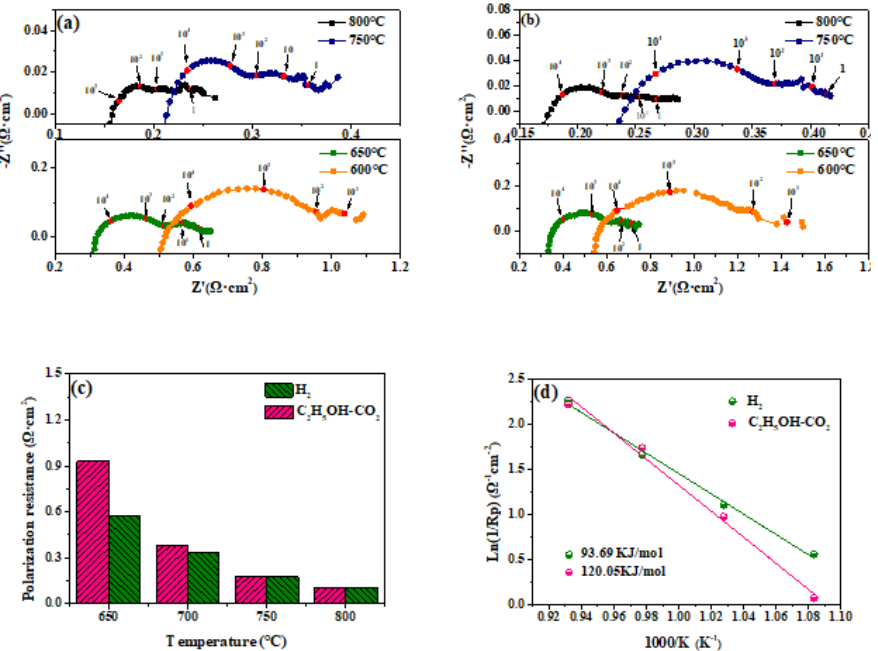
Figure 7. EIS of single cell with N-LSCFC-GDC reforming catalyst from 800 °C to 650 °C in ( a ) H 2 (~3% H 2 O) and ( b ) C 2 H 5 OH-CO 2 atmosphere; ( c ) R p comes from impedance spectra; ( d ) Arrhenius’s plots of the simulated R p values from ( c ).